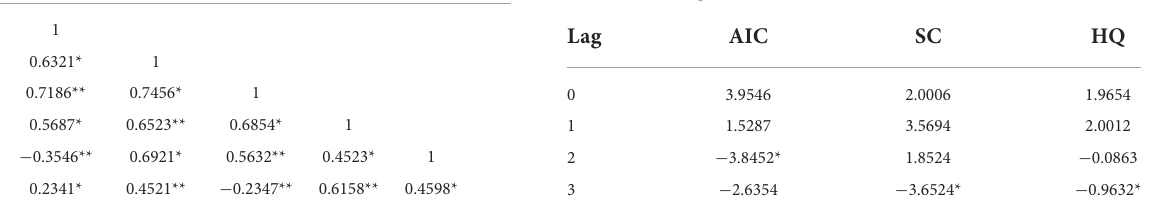
TABLE 5 VAR lag order selection